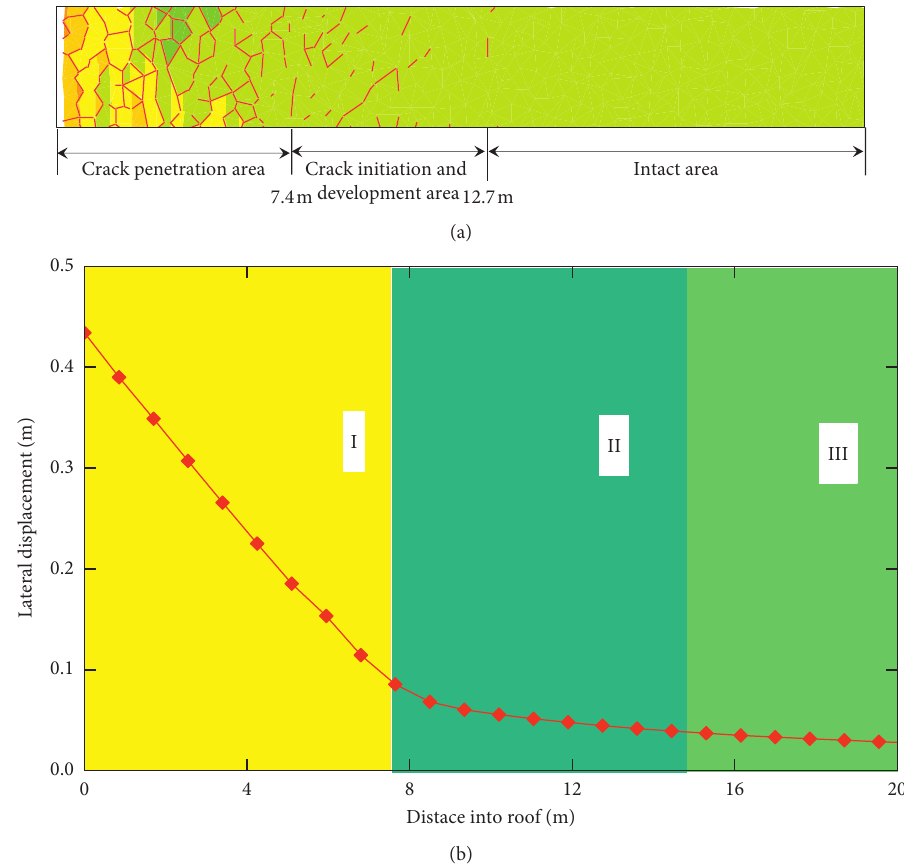
Figure 10: Relationship between crack development characteristics and deformation: (a) crack development characteristics and (b) deformation.